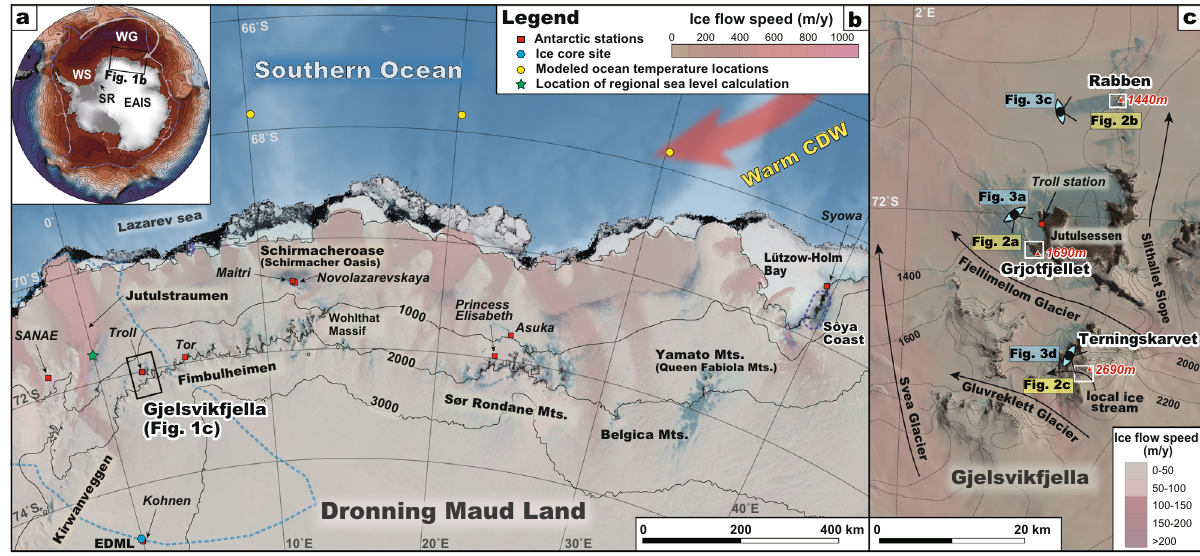
Fig. 1 Study area. a Antarctica and the Southern Ocean. Antarctic shading indicates ice sheet elevation, and Southern Ocean contours show the vertically integrated transport stream function 78 . Red (blue) colors indicate a cyclonic (anticyclonic) circulation, and the Weddell Gyre is highlighted by a white arrow. Contour intervals are 10 Sv (1 Sv = 1.0 × 10 6 m 3 s − 1 ). EAIS East Antarctic Ice Sheet, SR Shackleton Range, WS Weddell Sea, WG Weddell Gyre. The black box marks the location shown in b . b Overview of Dronning Maud Land and the location of the Gjelsvikfjella study area (black box, c ) within the Jutulstraumen catchment (blue dashed line). The yellow circles and green star are locations where seawater temperatures are extracted from the atmosphere – ocean general circulation model 40 and regional sea-level change is calculated, respectively. The blue dashed line indicates the area of the Jutulstraumen catchment used for ice sheet model experiments. The red arrow shows the approximate fl ow direction of warmer Circumpolar Deep Water (CDW). c Overview of Gjelsvikfjella, including Rabben, Grjotfjellet, and Terningskarvet. Arrows indicate the direction of ice fl ow. Small white boxes correspond to Fig. 2a – c. Blue eyes indicate approximate locations for the photographs of Fig. 3. The base map is from the Quantarctica GIS data package 79 for QGIS. Ice velocities 80 and ice surface contours 81 (every 100 m) are overlain on the Landsat Image of Antarctica (LIMA) 82